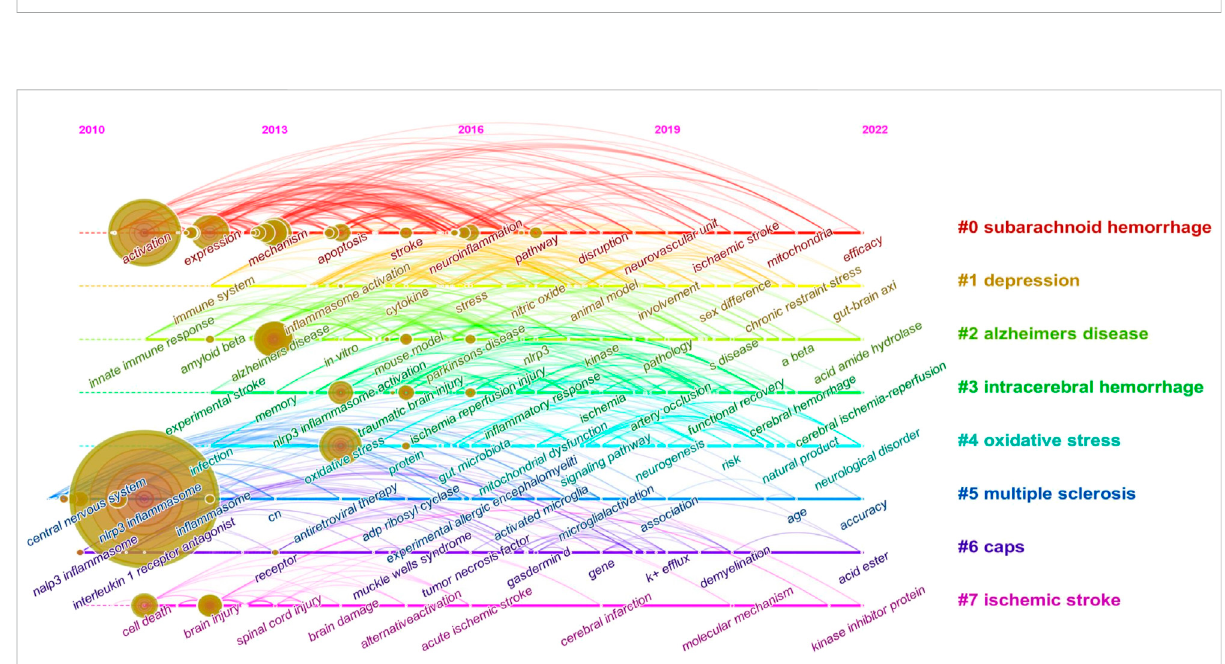
FIGURE 7 Keywords co-occurrence network. The size of the node represents the count of keywords. The top ten co-occurrence keywords are “ nlrp3in fl ammasome ” , “ activation ” , “ oxidativestress ” , “ expression ” , “ alzheimersdisease ” , “ nfkappab ” , “ mechanism ” , “ brain ” ,and “ celldeath ” .Theright part of the fi gure illustrates the major diseases associated with NLRP3 in fl ammasome, including “ alzheimers disease ” , “ ischemic stroke ” , “ traumatic braininjury ” ,and “ multiplesclerosis ” .ThekeywordsrelatedtotheNLRP3in fl ammasomeactivationpathwaysareshowninthelower-leftcorner of the fi gure, such as “ nf kappab ” and “ il-1 beta ” . Keywords related to the mechanism of NLRP3 in fl ammasome activation are indicated in the upper- left corner of the fi gure, including “ oxidative stress ” , “ apoptosis ” , and “ neuroin fl ammation ” .